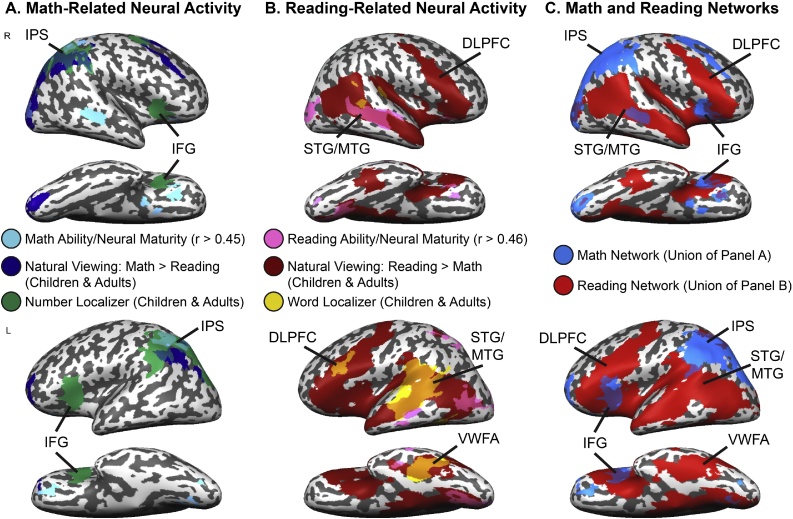
Functional networks for mathematics and reading. Analyses that identify math-related neural activity (A) and reading-related neural activity (B). Analyses in panels A and B draw on data from the natural viewing tasks (correlations between neural maturity and cognitive skills in light blue and pink, GLM analysis of mathematics video clips vs reading video clips in navy and red) and on data from the controlled localizer tasks (number task in green, word task in yellow). Supplement 3 presents a complete list of regions in these panels. Panel C shows the union of the analyses from Panel A in blue (the “mathematics network”) and the union of analyses from Panel B in red (the “reading network”). All results were significant at a voxel-wise p < 0.01, cluster corrected to p < 0.05. Maps are displayed with an arbitrary cluster threshold of 25 mm2. IPS = intraparietal sulcus, IFG = inferior frontal gyrus, STG/MTG = superior/middle temporal gyrus, DLPFC = dorsolateral prefrontal cortex, VWFA = visual word form area (For interpretation of the references to colour in this figure legend, the reader is referred to the web version of this article.).